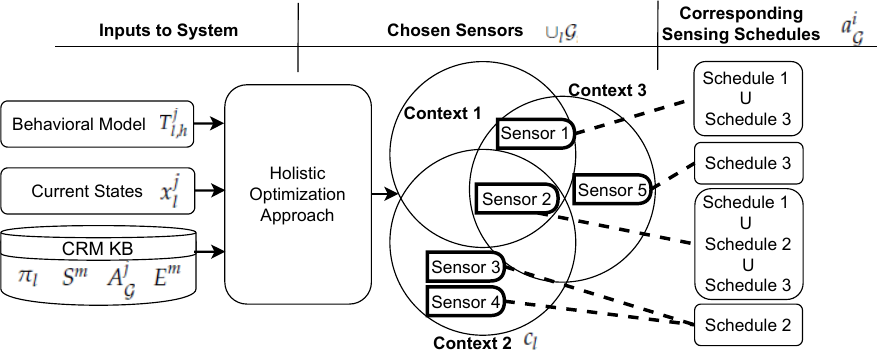
Figure 1. System description. The inputs are the user’s current context states, the behavior model, and a context recognition knowledge base (CRM KB). The outputs are the selected sensors and the sensing schedules for each context. The notation presented is described in Section